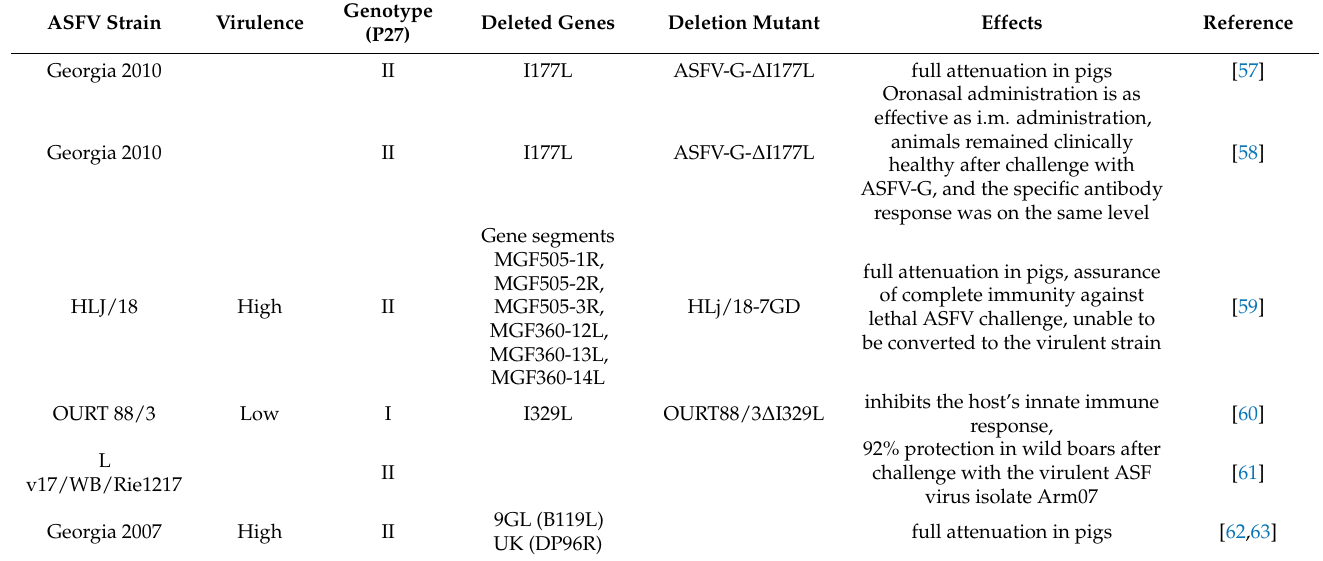
Table 2. Promising vaccines against ASFV developed in